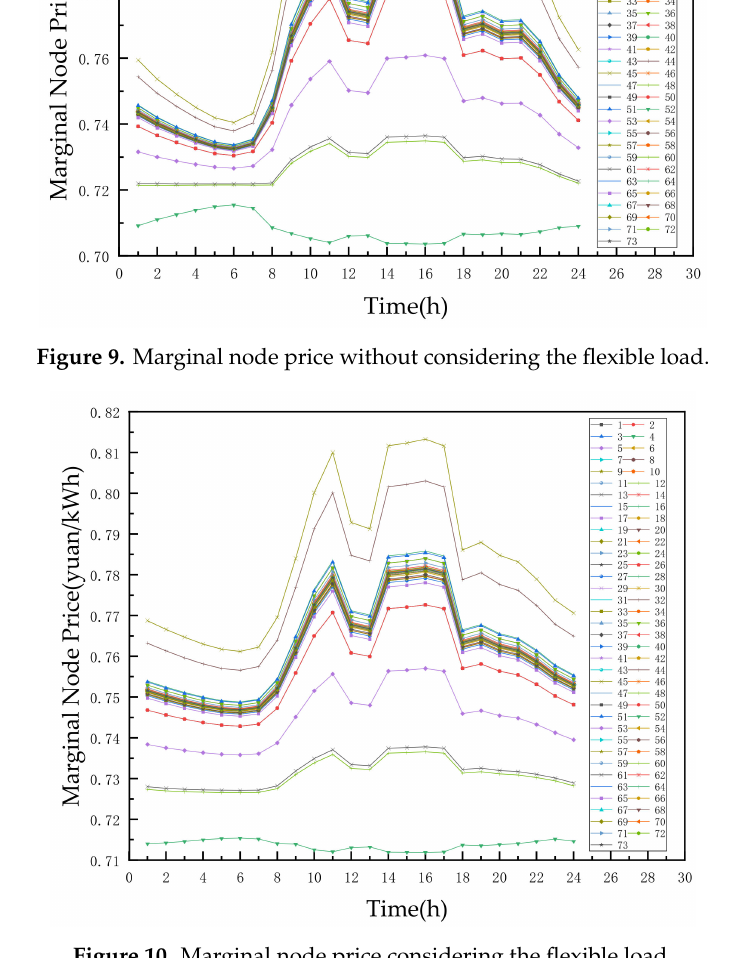
Figure 10. Marginal node price considering the flexible